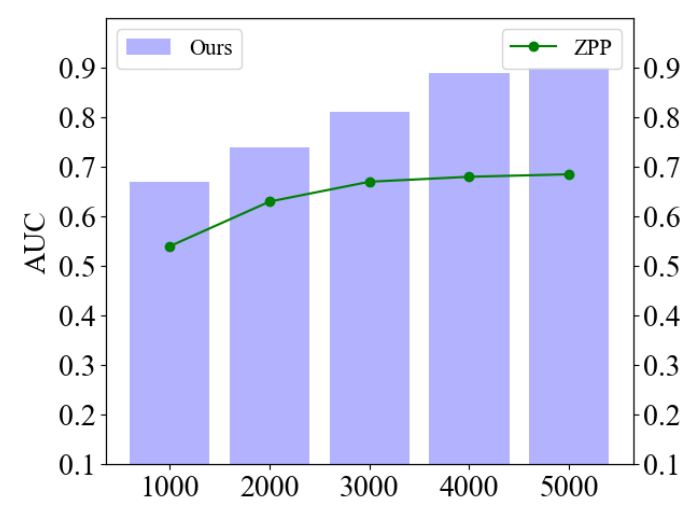
Figure 11. Comparison of the AUC of different models.